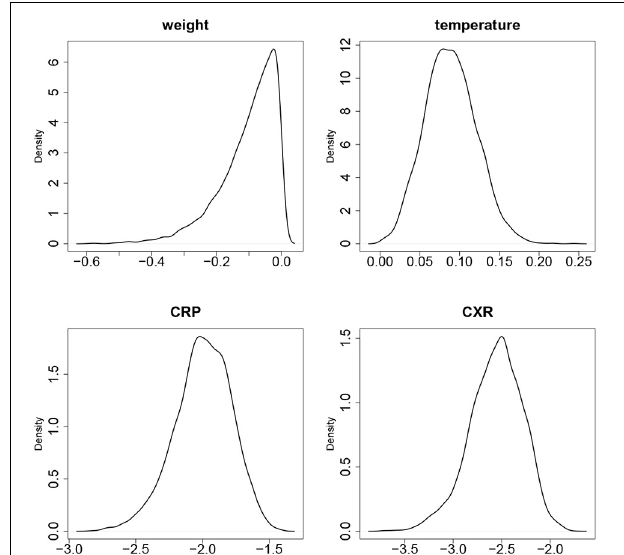
Table 3 | Best-fitting models for 4864 Unique Agilent Probe